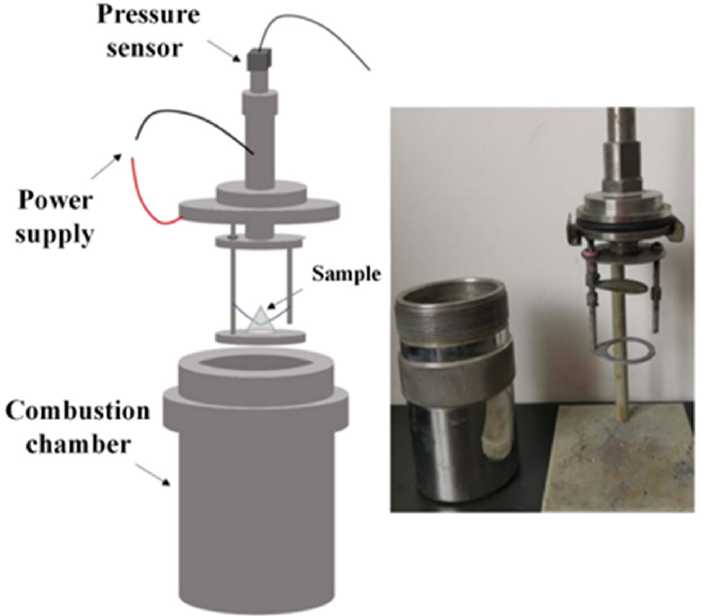
Figure 13. Diagram of a closed combustion chamber device.